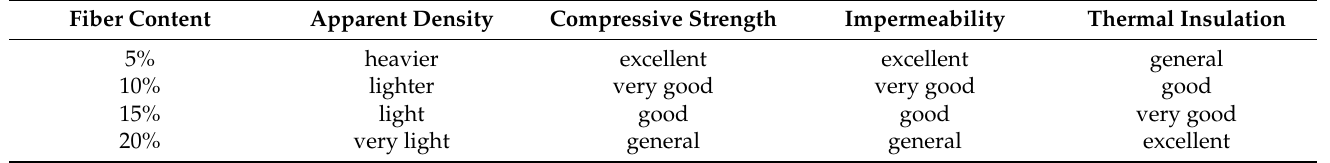
Table 4. Fiber content evaluation results.